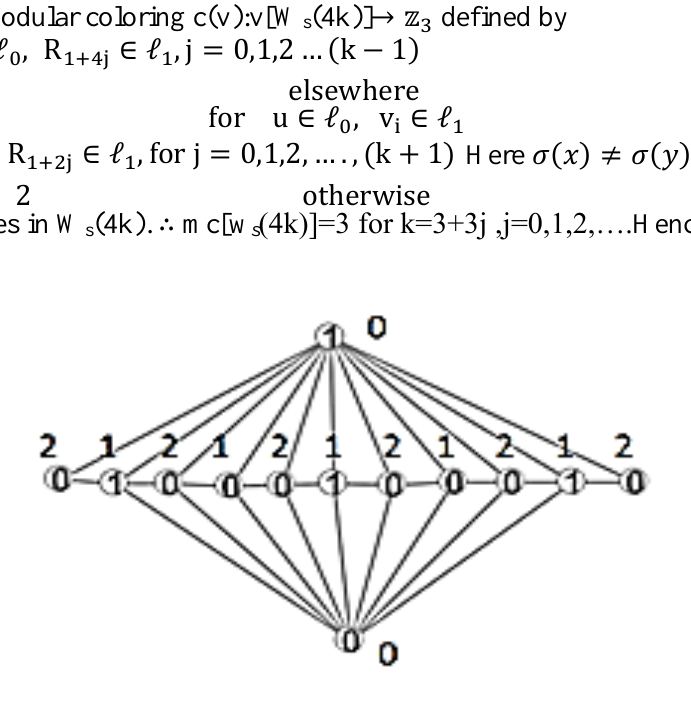
Figure 6 . Switching with modular coloring in